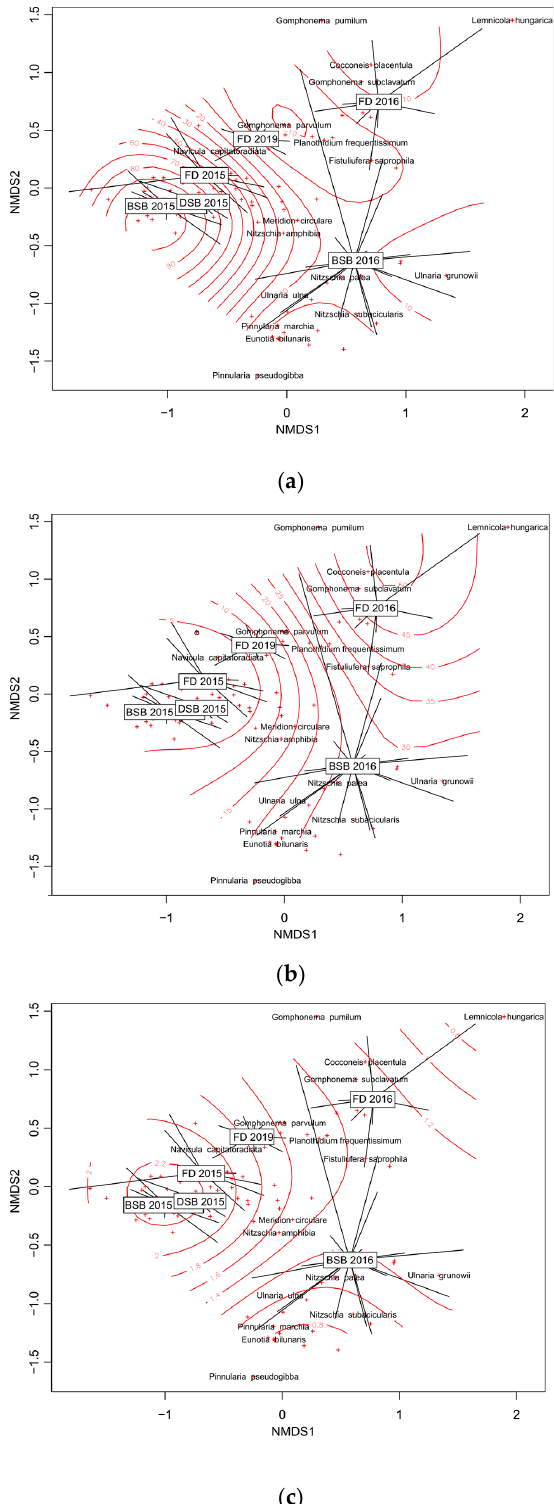
Figure 13. NMDS ordination diagrams of selected environmental factors and their relationship to species composition of diatom assemblages of the Dehtá ř fishpond. ( a ) Distance from the fishpond bank (m); ( b ) water depth (cm); ( c ) exposure to wave- or streaming-mediated disturbances (ordinal scale from 0—no disturbance, to 3—severe disturbances). The passively projected isolines in the figures demonstrate the scaling of each factor. For more information on environmental factors, see Table